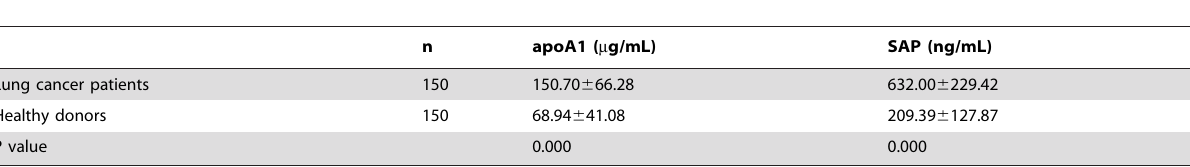
Table 4. Expression of apoA1 and SAP in serum of lung cancer patients and healthy